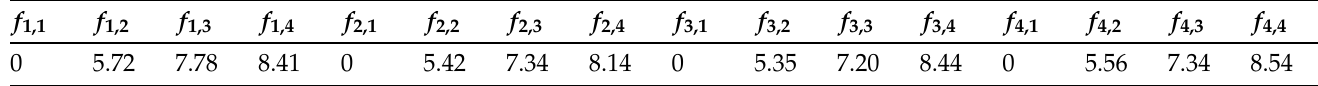
Table 2. Dominant tremor frequencies in Hz observed for the ET-diagnosed